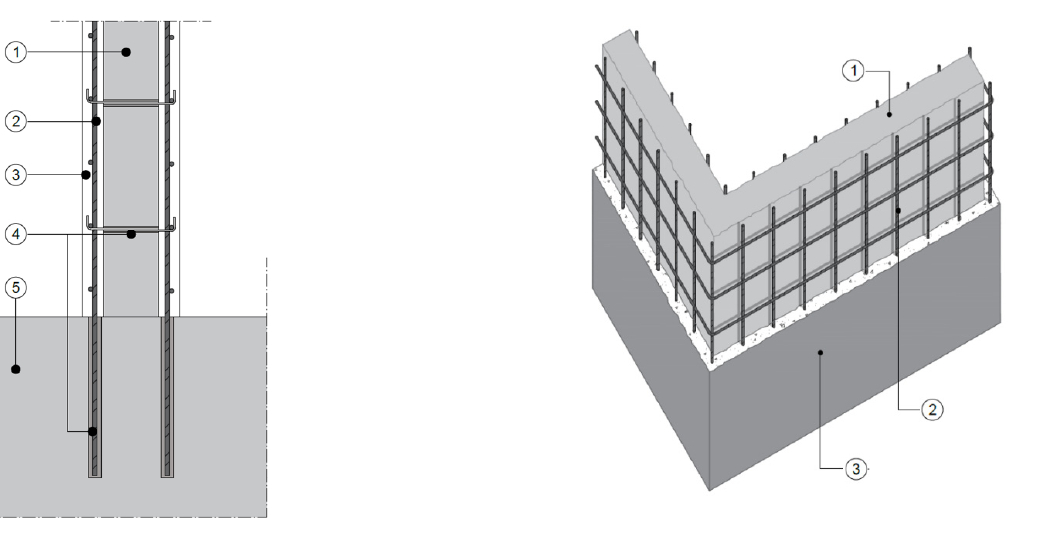
Figure 11. Construction details of the reinforced concrete jacketing. ( 1 ) Existing RC wall; ( 2 ) Rebars of the RC jacketing; ( 3 ) New concrete; ( 4 ) Detail of connection be-tween the new concrete walls and the existing foundation; ( 5 ) Existing foundation. Table 11. Steel reinforcing bars for I1 intervention ( ζ E ≥